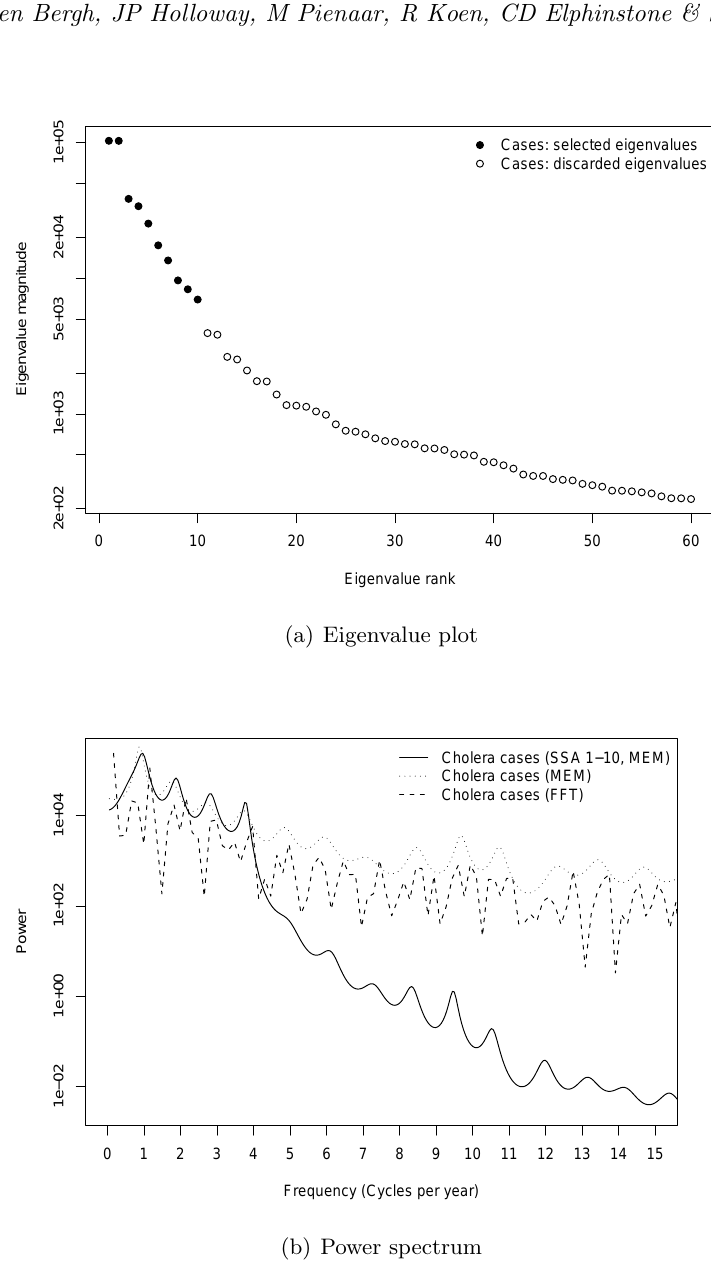
Figure 3: Eigenvalue plot and Power spectrum of cholera case data. The eigenvalues of part (a) were obtained using SSA. The power spectrum of part (b) was obtained by applying MEM to an SSA reconstruction of the cholera case data. The MEM power spectrum of the original cholera case data is provided for